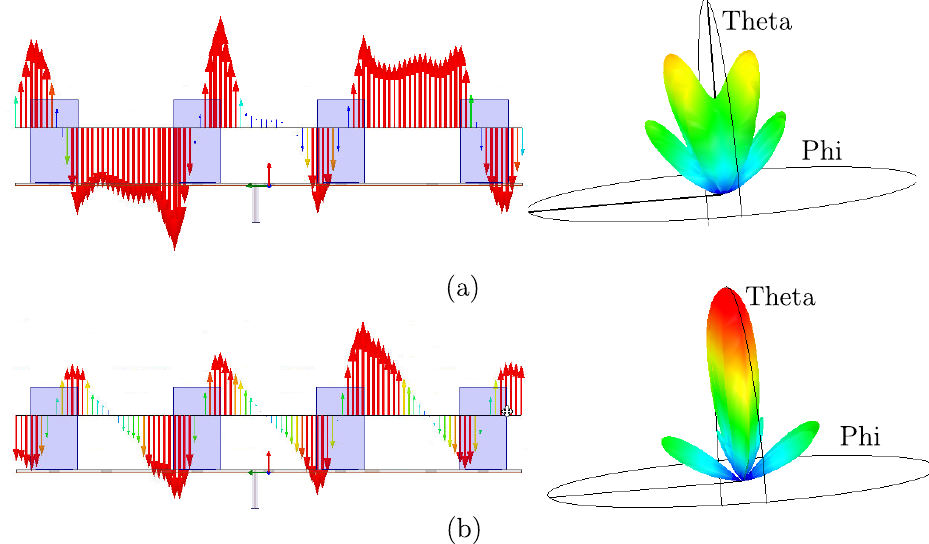
Figure 7. Field distribution and radiation pattern of proposed four-element DRA array ( a ) without and ( b ) with shorting